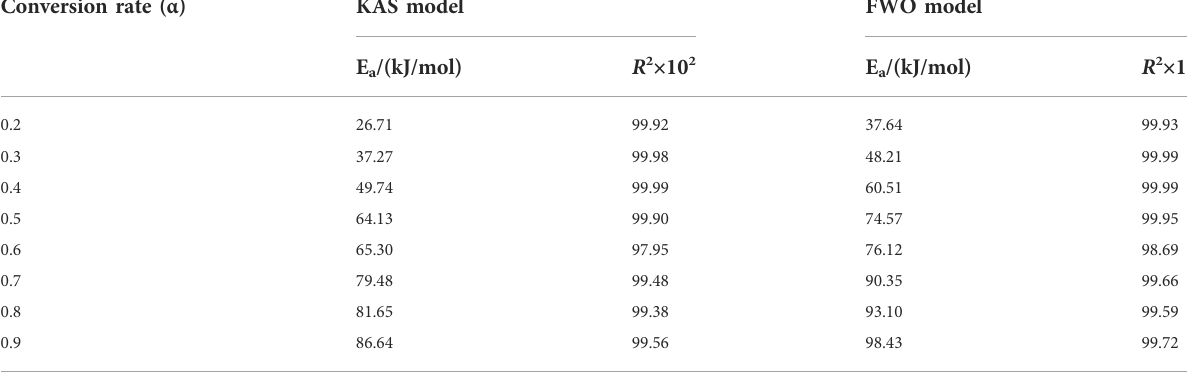
TABLE 1 Kinetic parameters at different conversion rates α (KAS and FWO